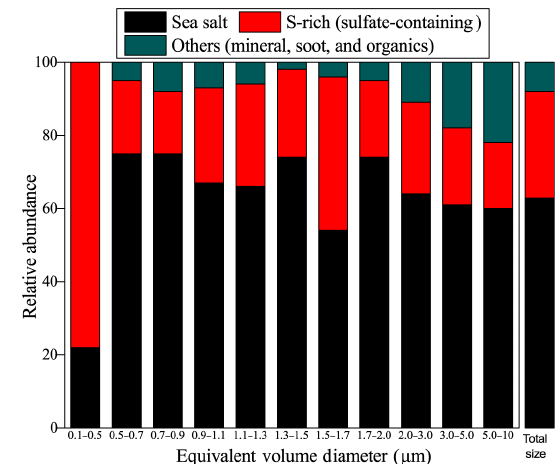
Figure 3. Relative abundances of typical individual aerosol parti- cles in the analyzed samples. Sulfate-containing particles include all particles that are an internal mixture of sulfate and OM, with or without